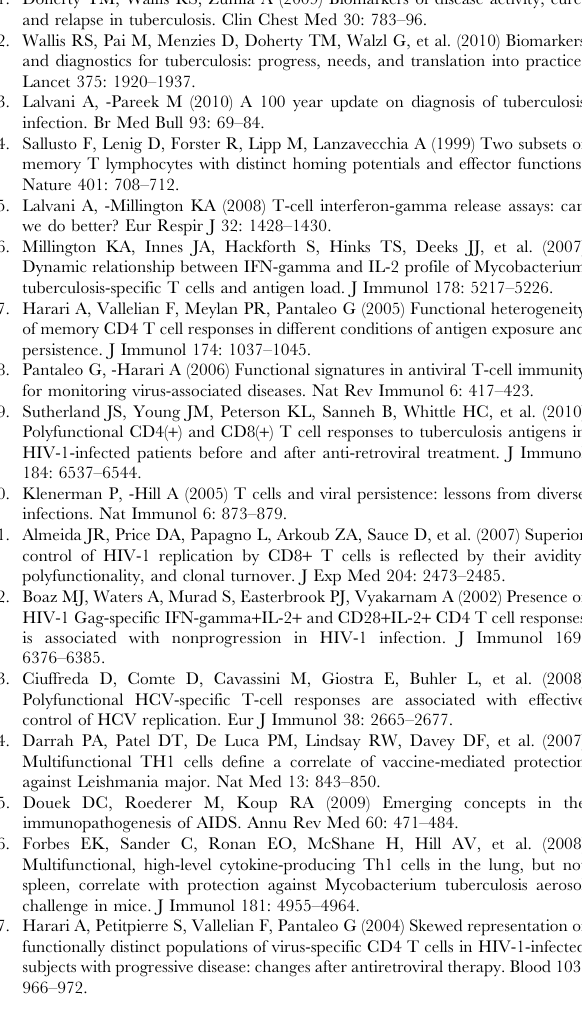
Table S1 Camera and count settings used on automated reader for colour-ELISpot and fluorescence-immunospot for all samples studied. Table S2 Concordance between assay results from colour- ELISpot and